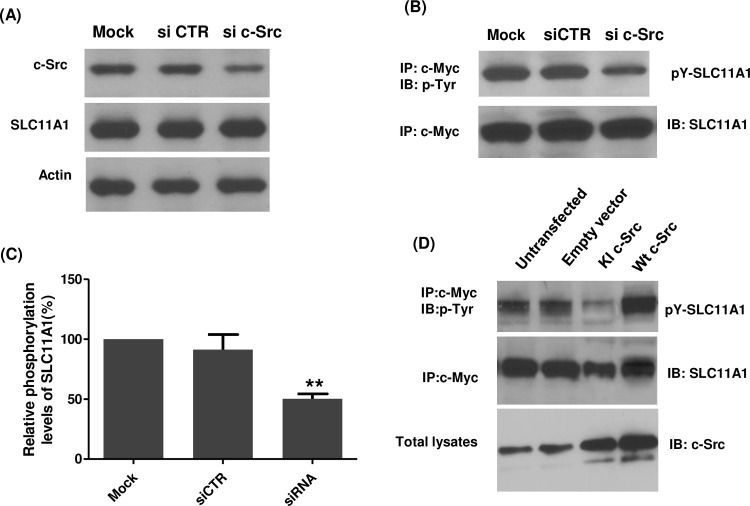
Effects of c-Src knockdown or overexpression of kinase-inactive c-Src on the tyrosine phosphorylation of SLC11A1.U937-SLC11A1 cells were transiently transfected with mock (transfection reagents only), non-targeting scrambled siRNA (siCTR) or c-Src-specific siRNA for 24 h and were then treated with PMA for another 48 hrs. (A) Protein extracts from mock transfected, non-targeting siRNA transfected, or c-Src siRNA transfected cells were prepared, and expression of c-Src, SLC11A1 and β-actin was detected by Western blot analysis using corresponding specific antibodies. (B) Protein extracts were immunoprecipitated with a mouse monoclonal antibody 9E10. Immunoprecipitates were separated on a SDS-PAGE gel, and were probed with antibody 4G10 to phosphotyrosine. The Western blots were stripped and re-probed with an antibody against SLC11A1. (C) The level of SLC11A1 phosphorylation in (B) was quantified by densitometry analysis and normalized to the level of total SLC11A1 protein. The relative phosphorylation level of SLC11A1 in mock-treated cells was set as 100%. Data represented as mean ± S.E.(n = 3) Compared with mock-treated group, **P<0.01. (D) U937-SLC11A1 cells were transiently transfected with empty plasmid (pCB6), plasmid expressing wild type c-Src (pCB6-Src) or expressing kinase-inactive c-Src (pCB6-KI-Src). 24 hrs after transfection, cells were treated with PMA for another 48 hrs and then lysed. Immunoprecipitation and immunoblotting were performed as in (B). Expression of c-Src was also analysed using an anti-c-Src antibody. The illustrated is a representative Western blot analysis showing the effect of c-Src knockdown or overexpression of KI-Src on SLC11A1 phosphorylation.